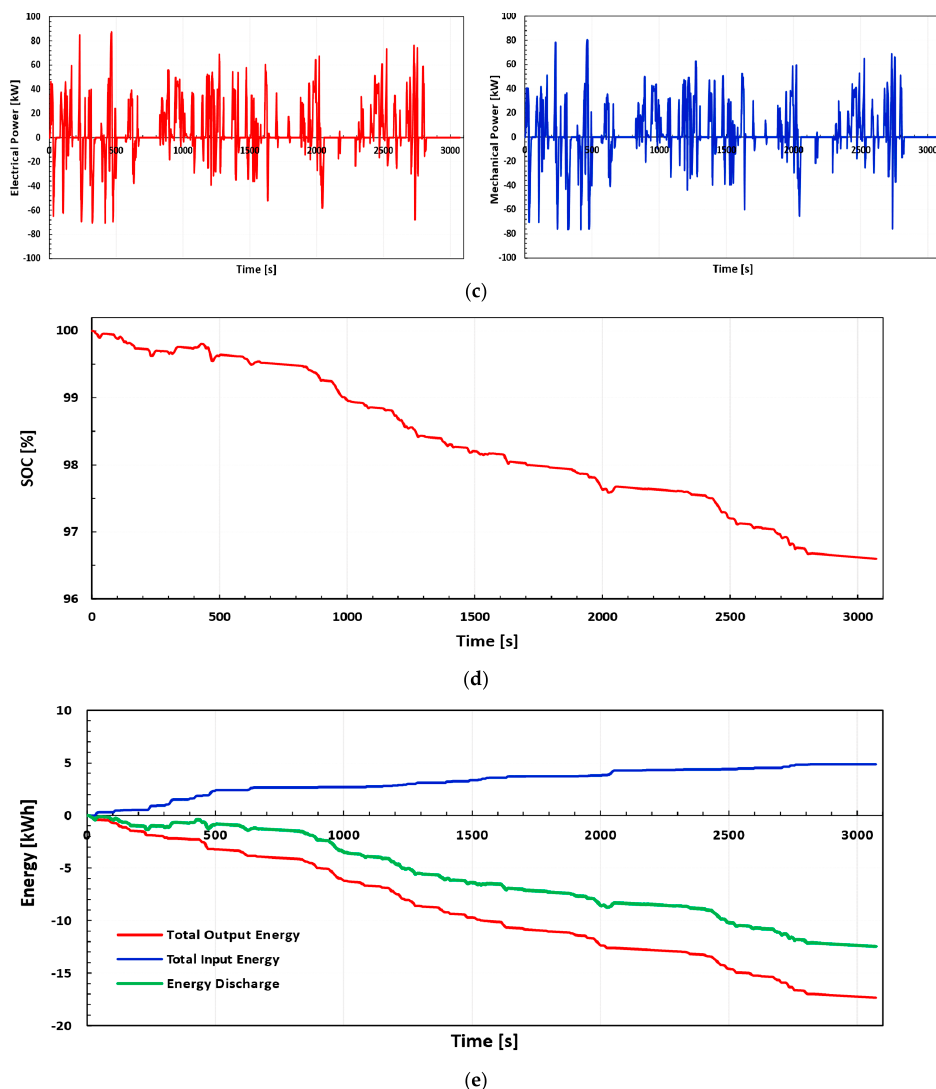
Figure 14. Route 1: ( a ) speed profile and cumulative energy consumption, ( b ) instantaneous power of traction battery, ( c ) electrical (red) and mechanical power (blue), ( d ) state of charge consumption during the cycle, and ( e ) energy consumption during the cycle.